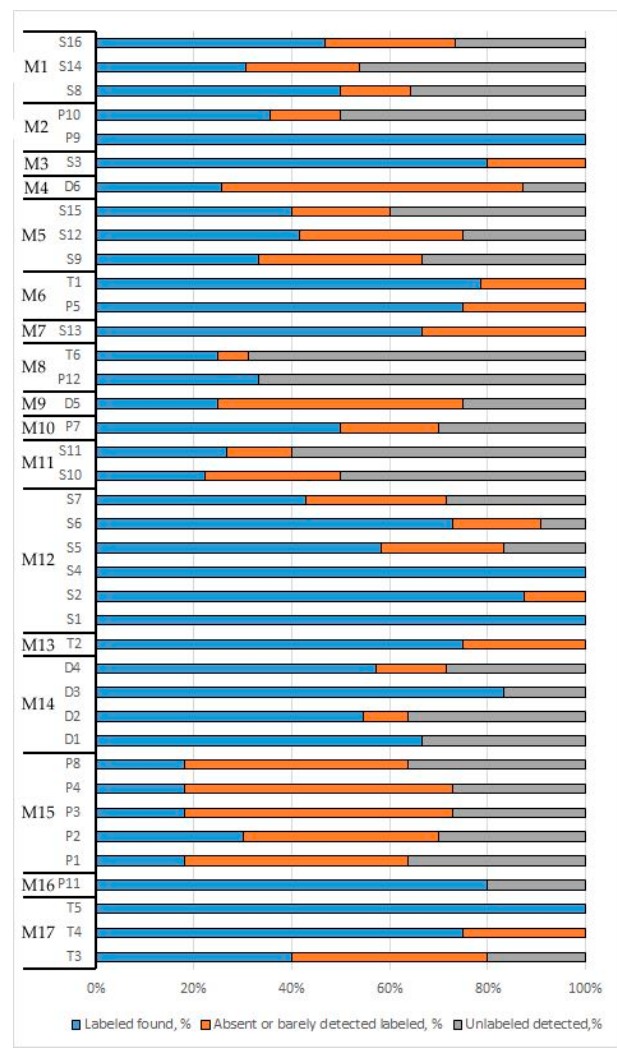
Figure 3. Species composition analysis results from (meta)barcoding. Total number of labelled and found extraneous plants was taken as 100%. Blue: found plants that match the labelled; orange; labelled plants not found or found below the 1% threshold; grey: contaminants. Samples were grouped by manufacturer (M) from 1 to 17.